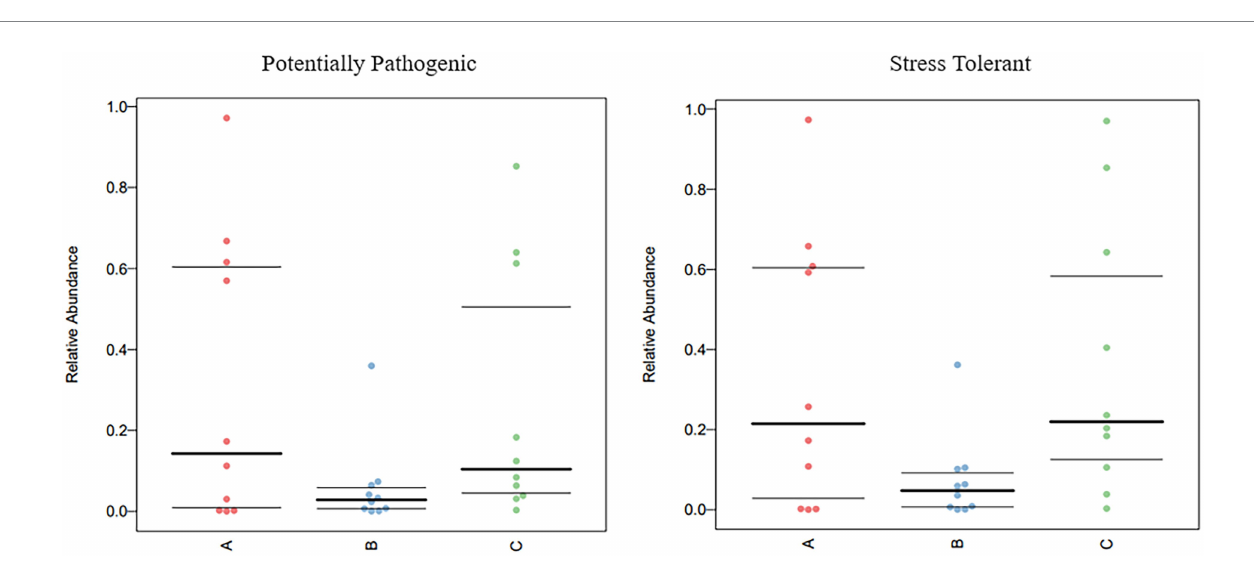
FIGURE 9 Comparison of bacterial phenotypes in samples. Scatter plots show the relative abundance of each sample in different phenotypes in different